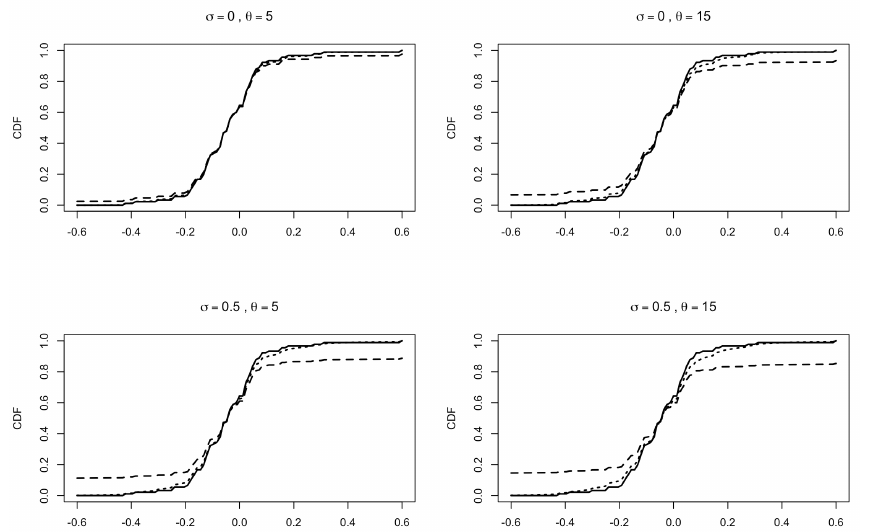
Figure 2. Predictive CDFs for the relative changes in larcenies between 1991 and 1995 (relative to 1991) for the 90 most populous US counties; data taken from Section 2.1 of [34]. Data have been rounded to the second decimal. Here, n = 90 and k = 36. Solid line: empirical CDF. Dotted line: predictive CDF from (33). Dashed line: predictive CDF from PS2 with H = T 2 α Different plots correspond to different values of θ and σ . In all the plots, the predictive CDFs are evaluated with µ 0 = 0, α 0 = 0.1, β 0 = 0.1 and k 0 = 0.1.